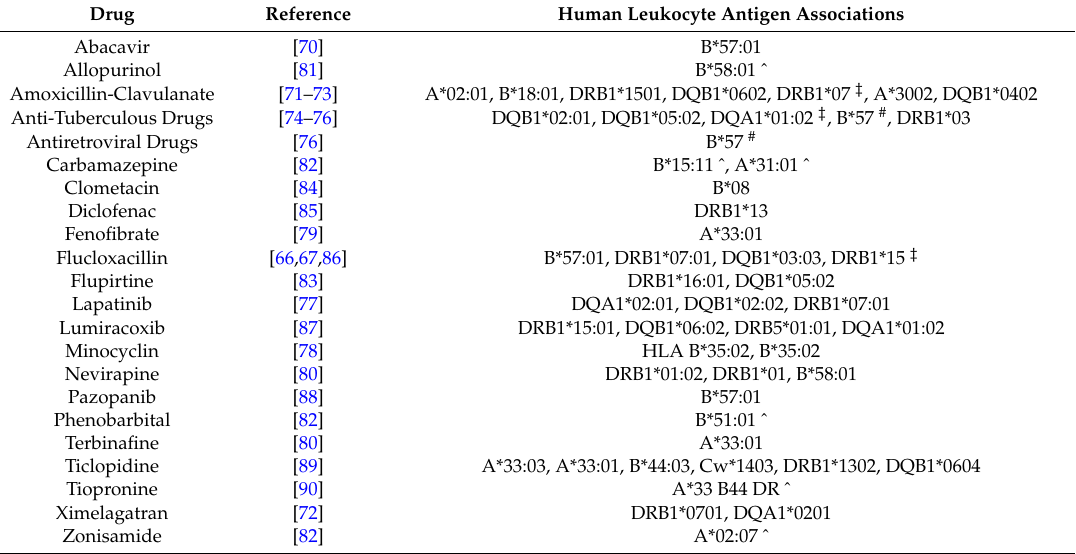
Table 1. Associations between human leukocyte antigen (HLA) and idiosyncratic drug-induced liver injury